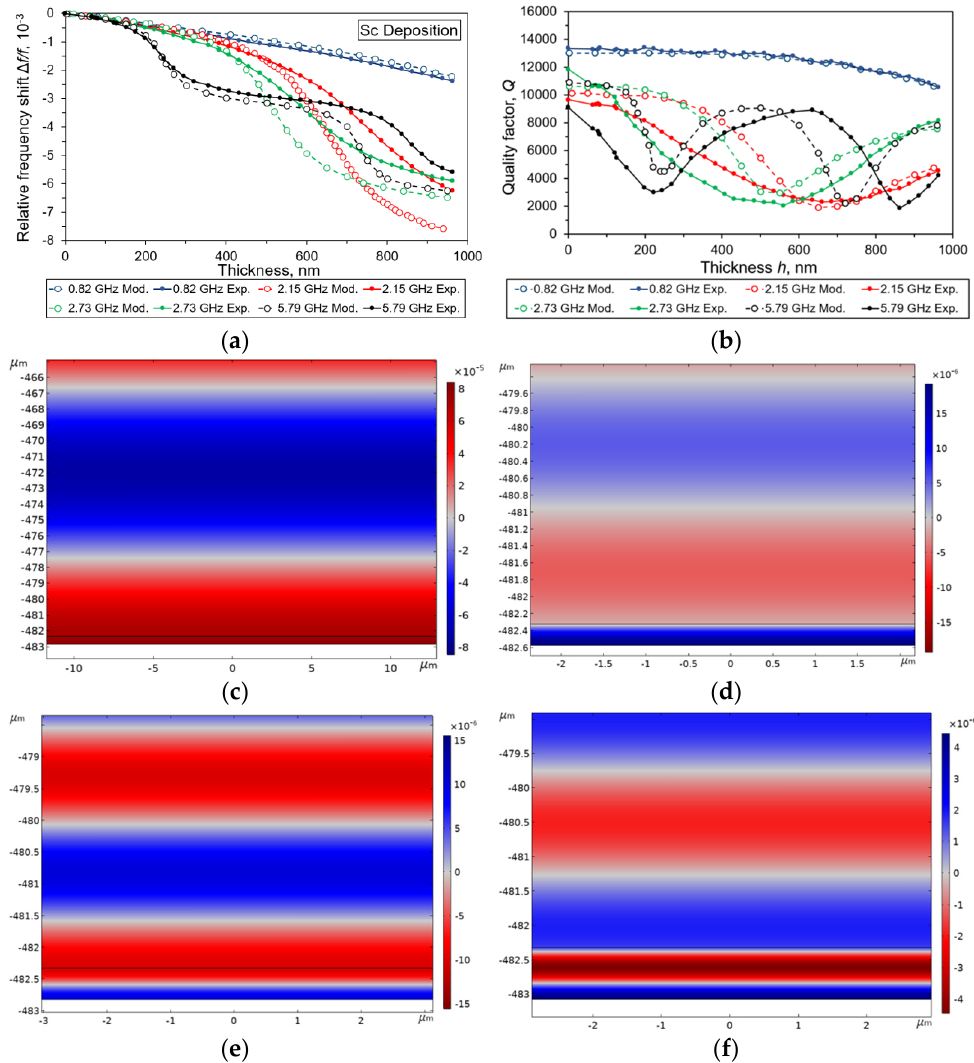
Figure 3. Relative frequency shift ( a ) and quality factor ( b ) vs. the Sc film thickness measured for the microwave acoustic overtones taken at four operational frequencies of sensor #A. Model distribution of the L-BAW vertical Y-component of elastic displacements when h = 500 nm at 0.82 GHz ( c ), h = 250 nm ( d ), 500 nm ( e ), and 750 nm ( f ) at 5.79 GHz.